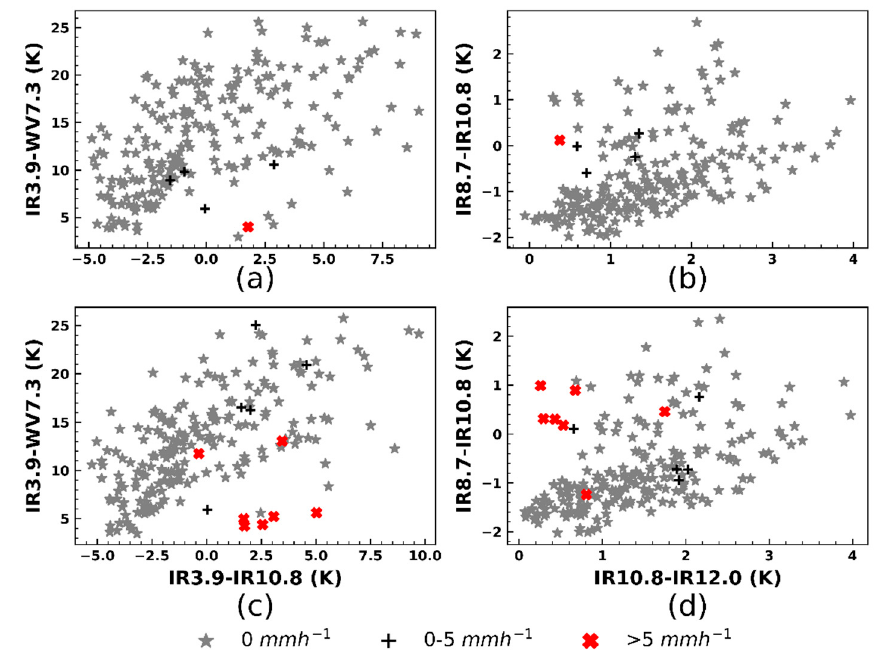
Figure 6. Nighttime R RG ( a , b ) and R MWL ( c , d ) as a function of ∆ T IR3.9-IR10.8 versus ∆ T IR3.9-WV7.3 , ( a , c ) and ∆ T IR10.8-IR12.0 versus ∆ T IR8.7-IR10.8 ( b , d ) for Kericho.